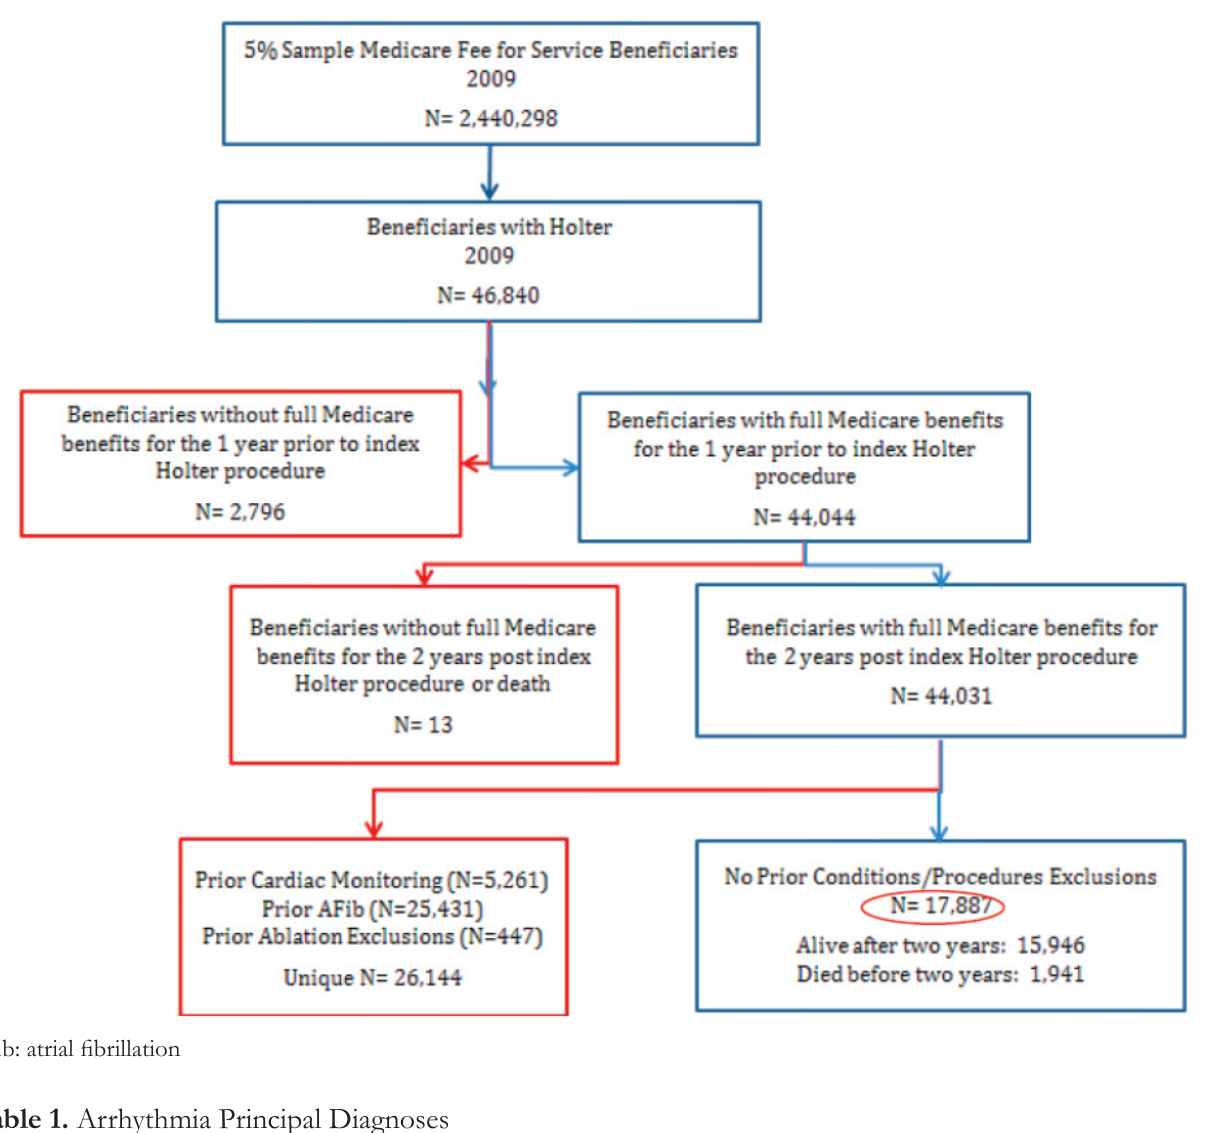
Figure 1. CONSORT Diagram